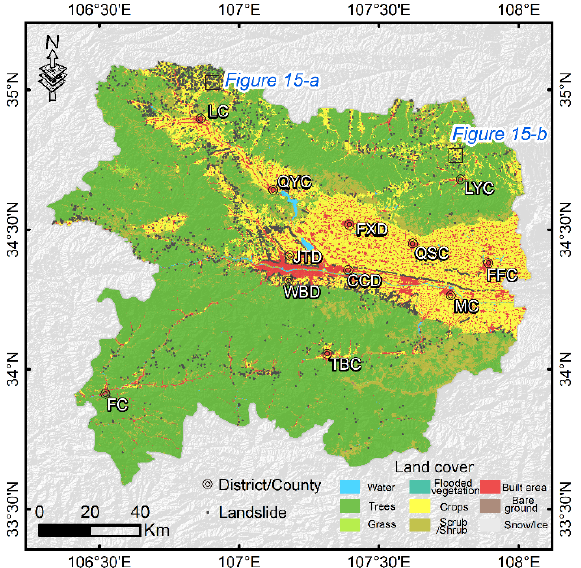
Figure 12. Land cover and landslide distribution in the study area. The districts and counties are shown in Figure 7.